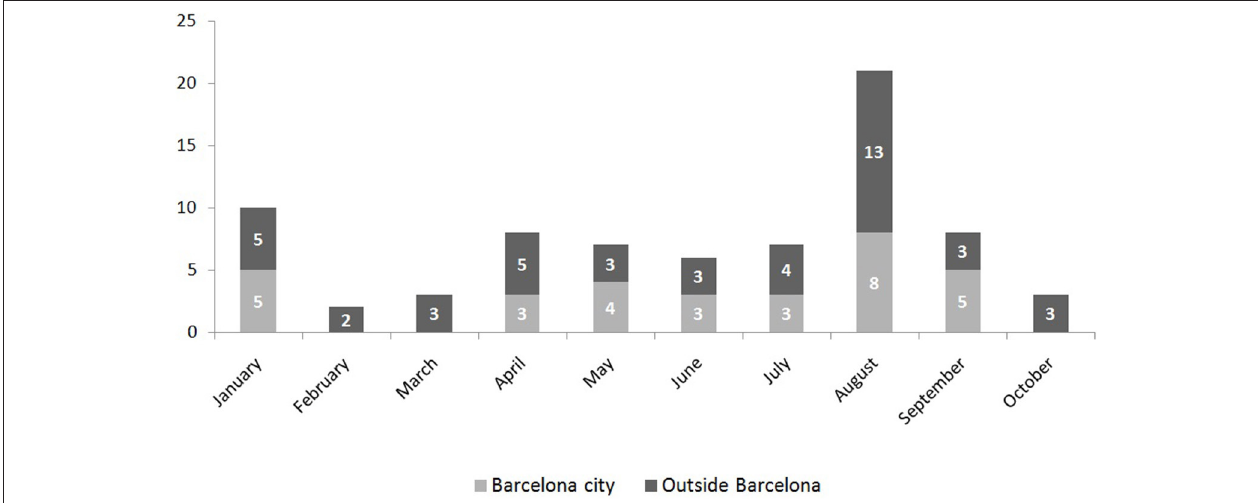
FIGURE 2 | Monthly distribution according to place of residence (living in the city or outside the city of Barcelona) of the first 75 confirmed cases of Zika virus infection in Barcelona. Period: January–December 2016.